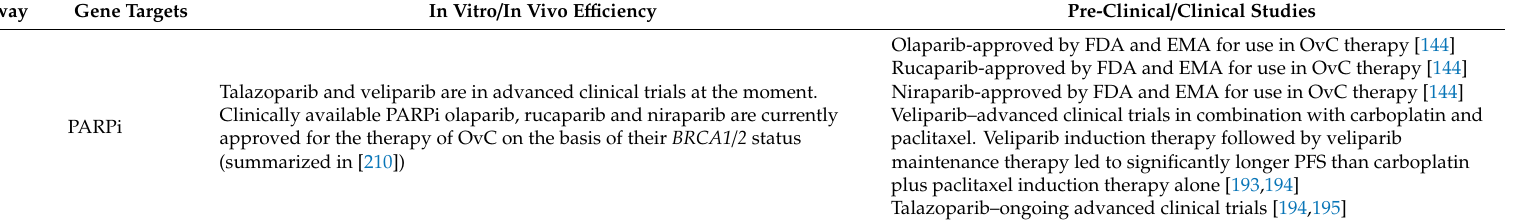
Table 2. Current promising therapeutic approaches targeting DNA repair system in